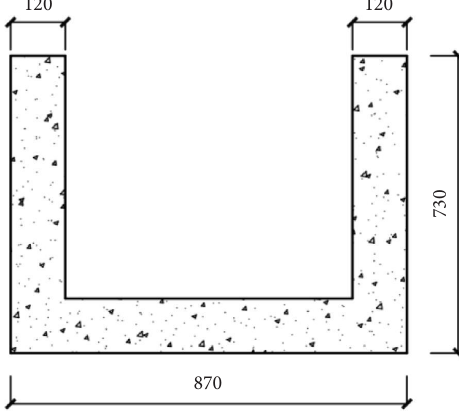
Figure 3: Model plane size drawing. Table 1: Specimen design